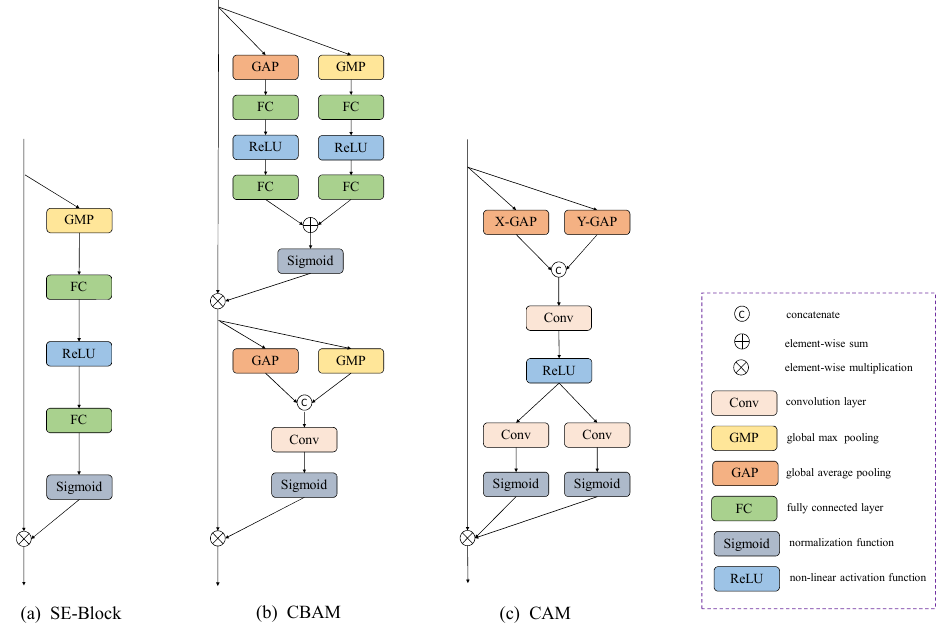
Figure 4. Structures of different attention mechanisms. X-GAP and Y-GAP are mean pooling in the x and y directions,